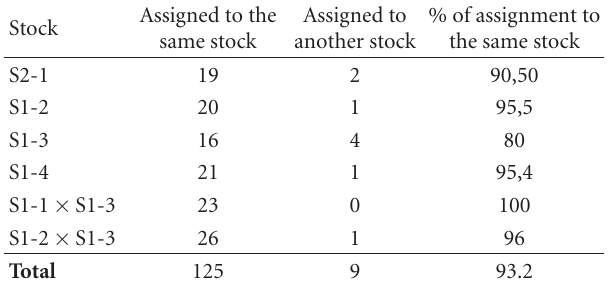
Table 2: Number of assigned individuals to the correspondent stock and/or to any other using the Bayesian assignment test [16] by GeneClass [17]. Simulations were run to determine the probability of assignment, using a probability of rejection set at P < 0 . 05.